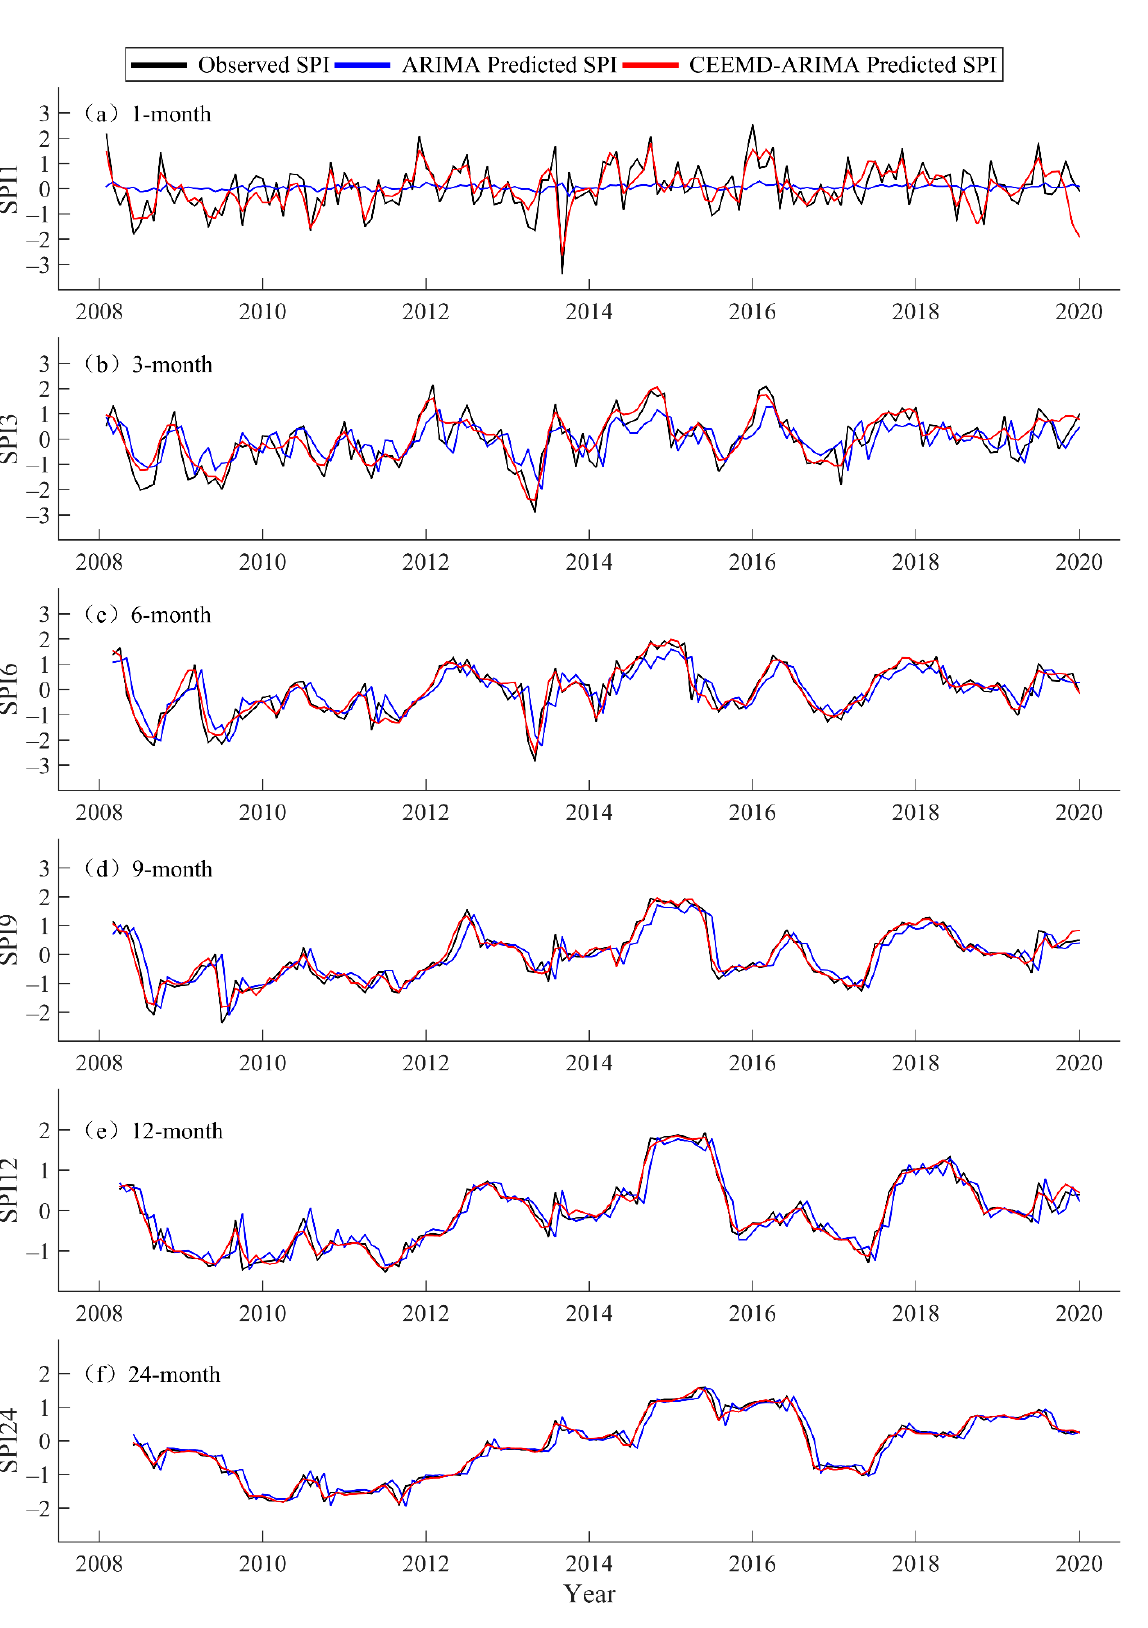
Figure 6. Comparison of the predicted and observed values of the SPIs on the 1-month ( a ), 3-month ( b ), 6-month ( c ), 9-month ( d ), 12-month ( e ), and 24-month ( f ) time scales of the ARIMA model and the CEEMD–ARIMA model at Tongxin Station (2008–2019).